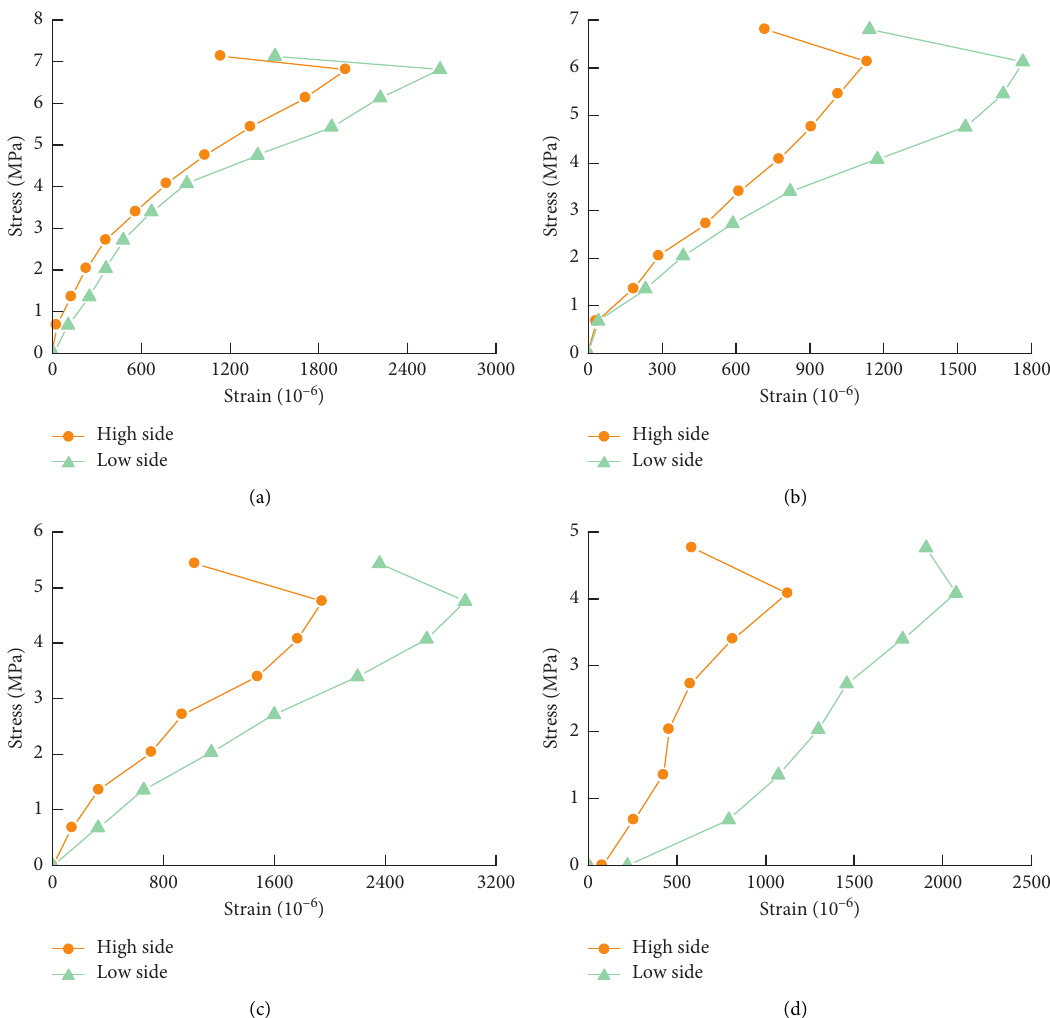
Figure 13: Stress-strain curve of the surrounding rock of the two sides of the roadway. (a) 18 ° . (b) 21 ° . (c) 24 ° . (d) 27 °